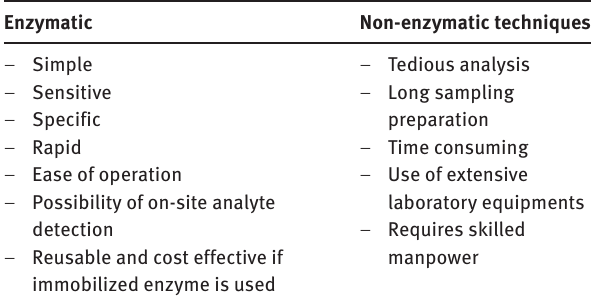
Table 1: Comparison of enzymatic and non-enzymatic techniques for nitrate